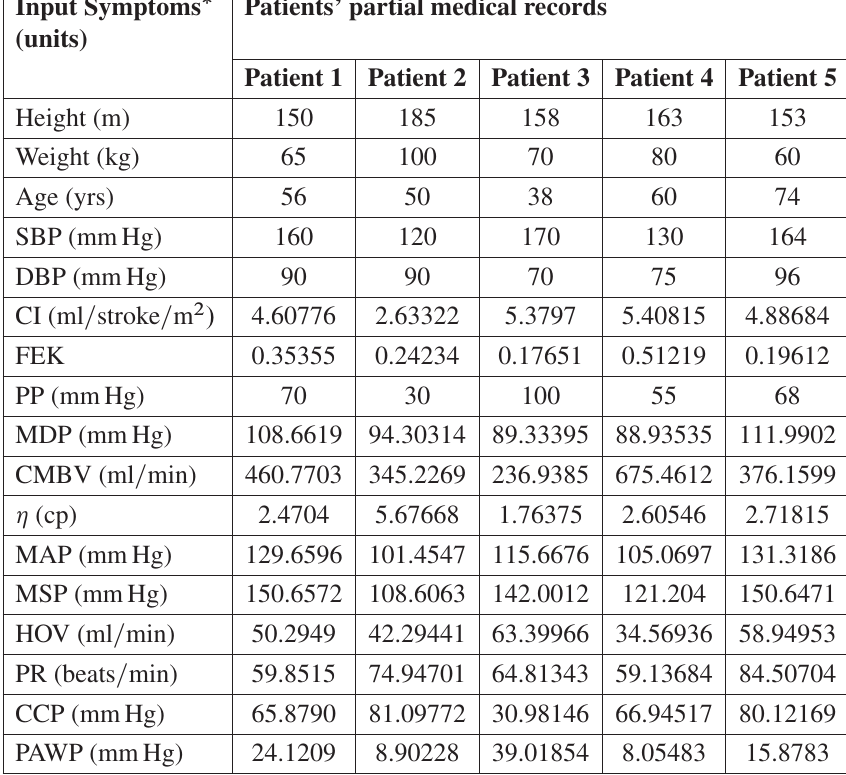
Table 4. Partial medical records sampled from five patients.